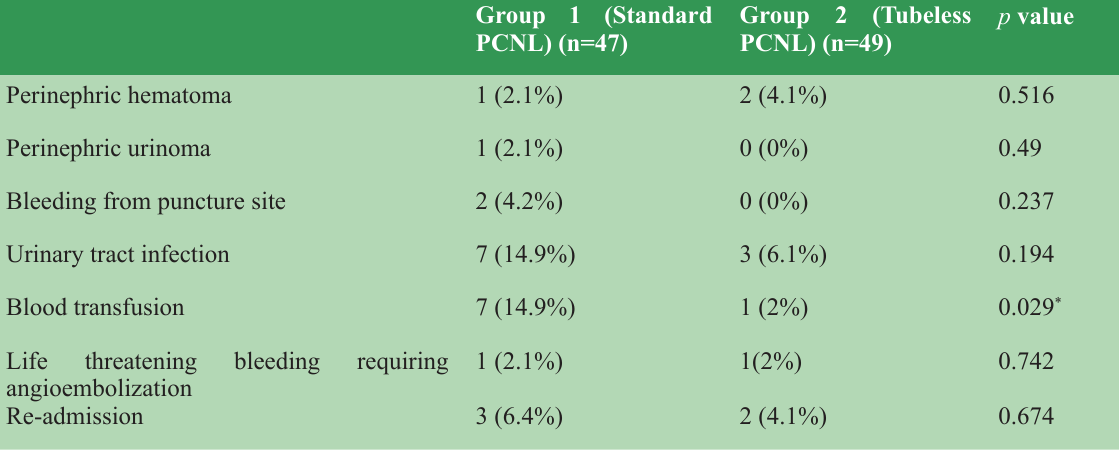
Table 3: The incidence of post PCNL complications and